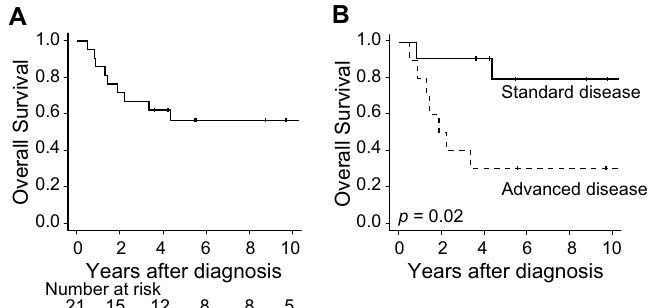
Figure 4. Overall survival after the initial diagnosis of T-LBL. ( A ) Overall survival after the time of initial diagnosis is shown, and ( B ) compared between standard- and advanced-disease